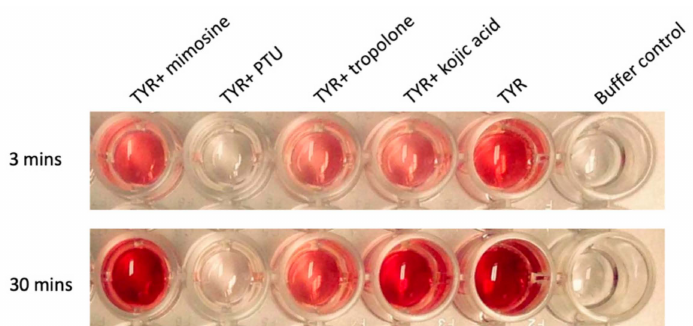
Figure 1. Colorimetric tyrosinase activity assay showing the inhibition by di ff erent inhibitors. The images were taken at 3 min (upper panel) and 30 min (lower panel) after the start of the reaction. The bu ff er control contained 0.5 mM 3-methyl-2-benzothiazolinone hydrazine hydrochloride hydrate (MBTH) and 2 mM L-3,4-dihydroxyphenylalanine (L-DOPA) in 40 mM phosphate bu ff er, pH 6.5. The other wells contained the bu ff er control condition with added 0.4 µ M tyrosinase (TYR) protein and 2 mM inhibitor, as indicated in the figure. PTU: